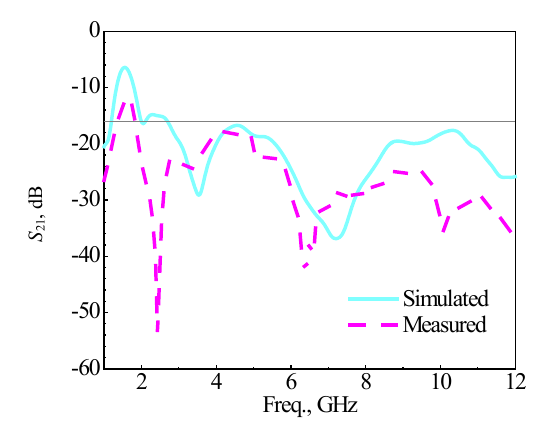
Fig. 4. Measured and simulated S 21 .